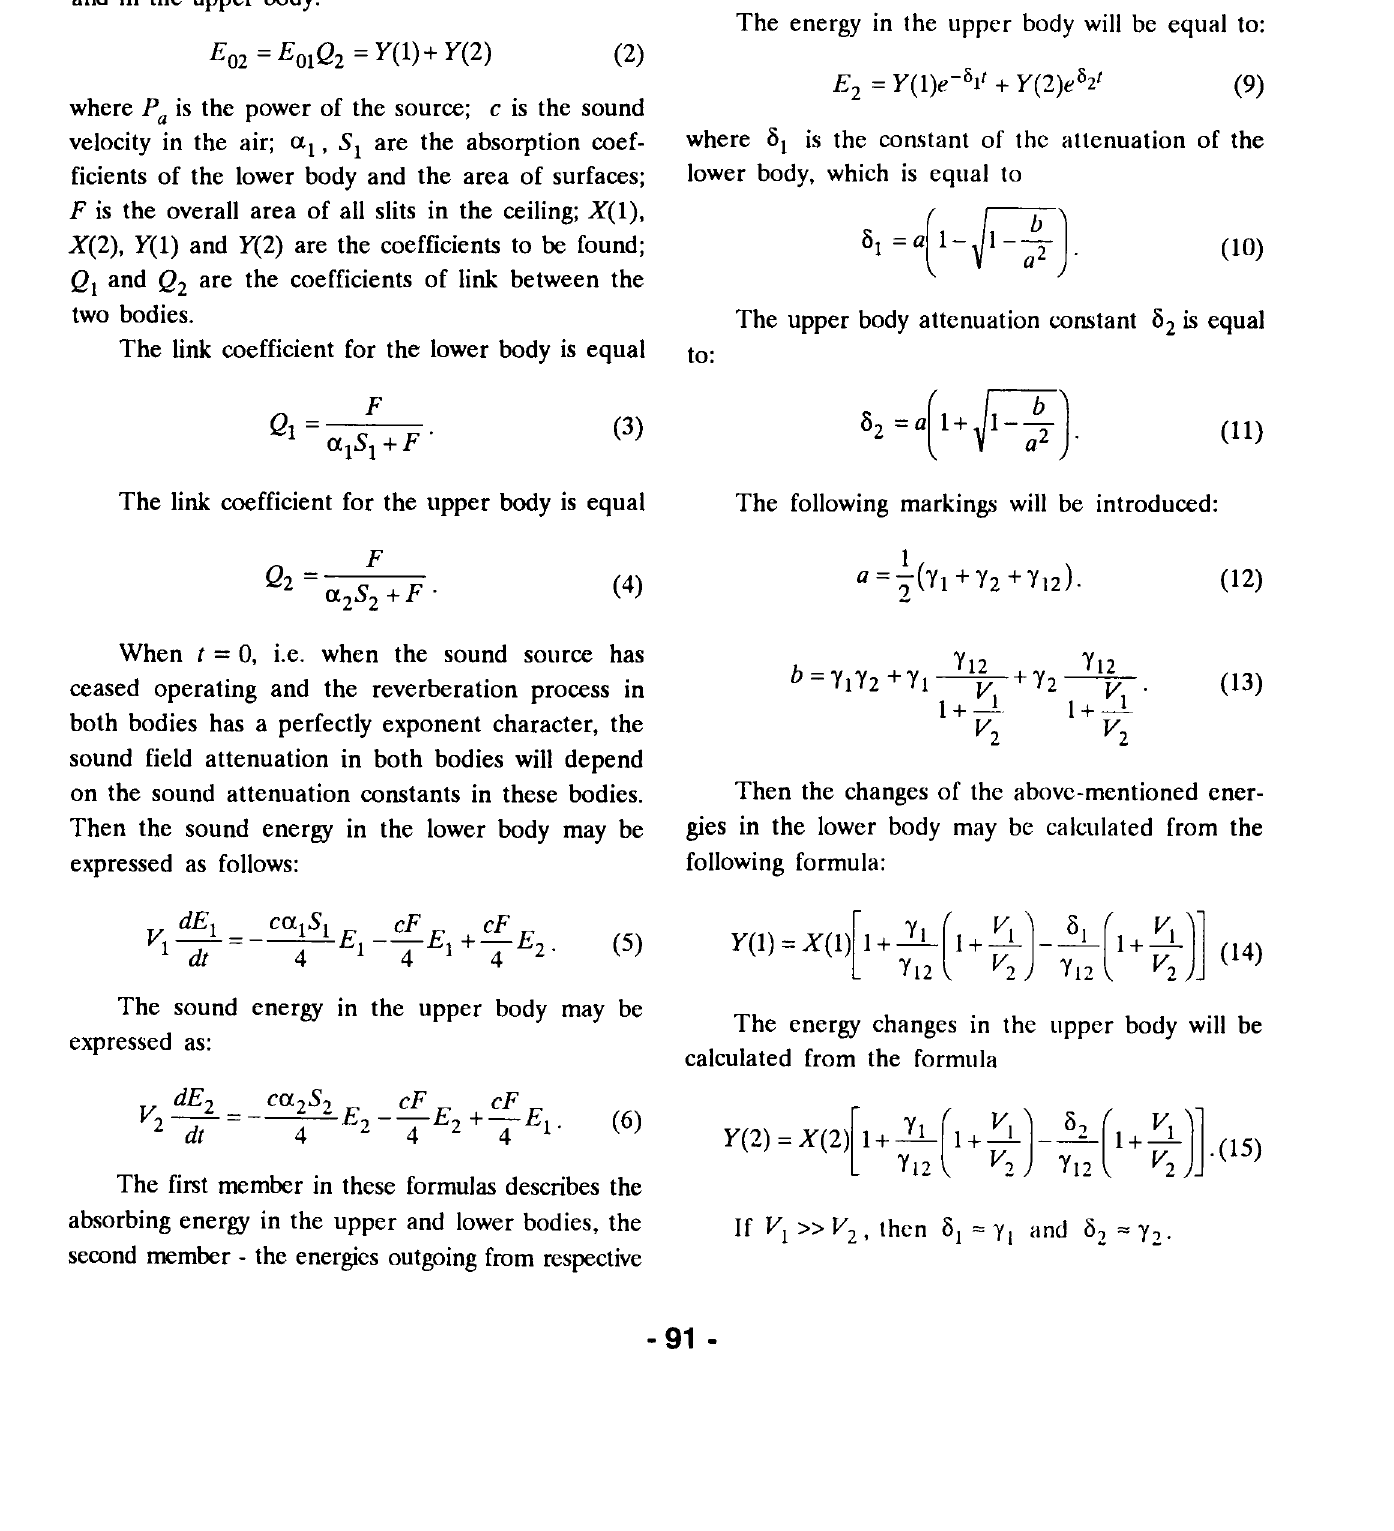
Fig 1. The distribution of the first sound reflections in the lower and upper bodies of the